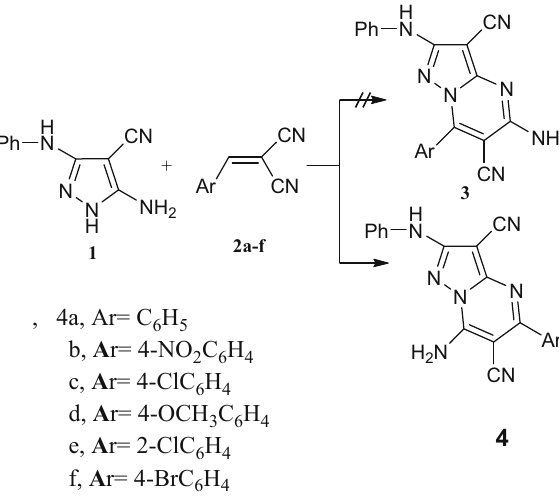
Scheme 1: The reaction of 5 - aminopyrazole derivatives 1 with ben - zylidene malononitrile derivatives 2 .